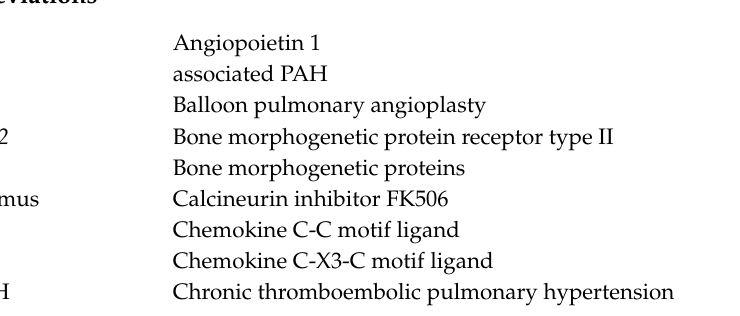
Table S1: Pre-clinical therapeutic targets in experimental